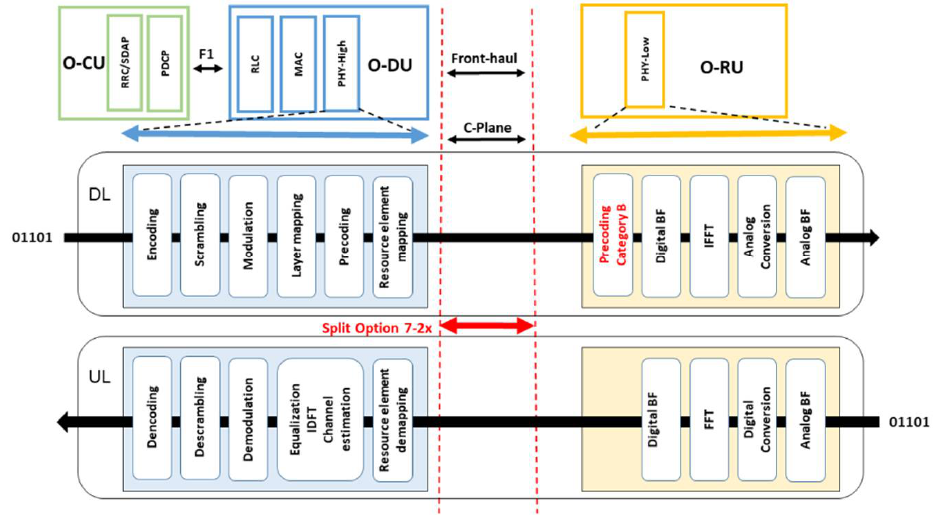
Figure 4. DL and UL block diagram in O-RAN. Category A: the precoding (digital beamforming) function is performed in O-DU, allowing the O-RU design to be simple. The front-haul interface will carry spatial streams in the downlink. Category A fits well in the case of low-frequency and latency-insensitive